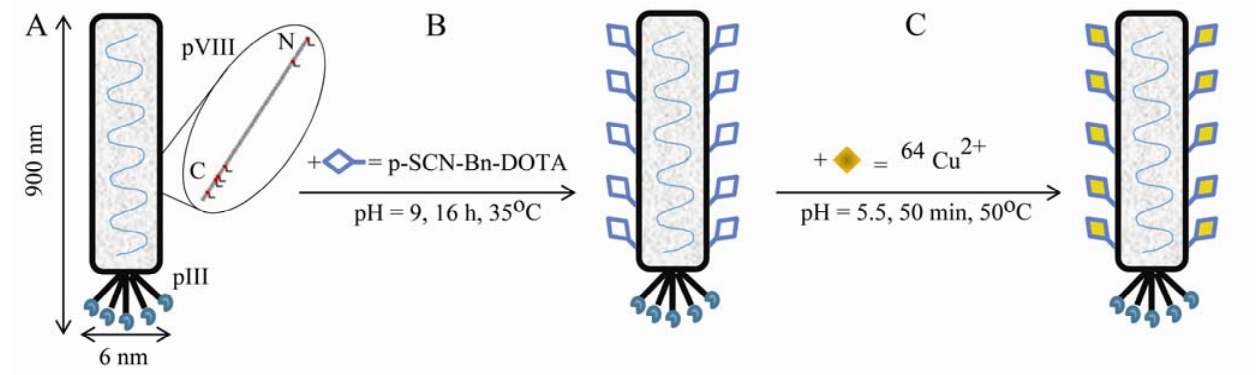
Figure 5. Design and synthesis of M13 phage-based molecularly targeted imaging platform for noninvasive assessment and visualization of in vivo peptide binding by positron emission tomography (PET). (A) M13 bacteriophage is a long filamentous particle approx. 6 nm in diameter and 900 nm in length. The viral genome is encapsulated in approx. 2700 copies of the major coat protein pVIII. The minor coat protein pIII that caps the particle is engineered to display five copies of a tumor-avid QFPPKLTNNSML peptide. Five lysine groups (Lys 8, 40, 43, 44, 48) and one N-terminal amino group (Ala 1) on each pVIII subunit are available for chemical modification [28]. (B) Bifunctional p- SCN-Bn-DOTA derivative is added to a 1 × 10 11 pfu phage in conjugation buffer at pH = 9. The chemical reaction for covalent attachment of DOTA to the phage surface is carried out for 16 hours at 35 °C. (C) The 64 Cu 2+ radiometal is attached through coordinative binding to the DOTA-phage construct for 50 min at 50